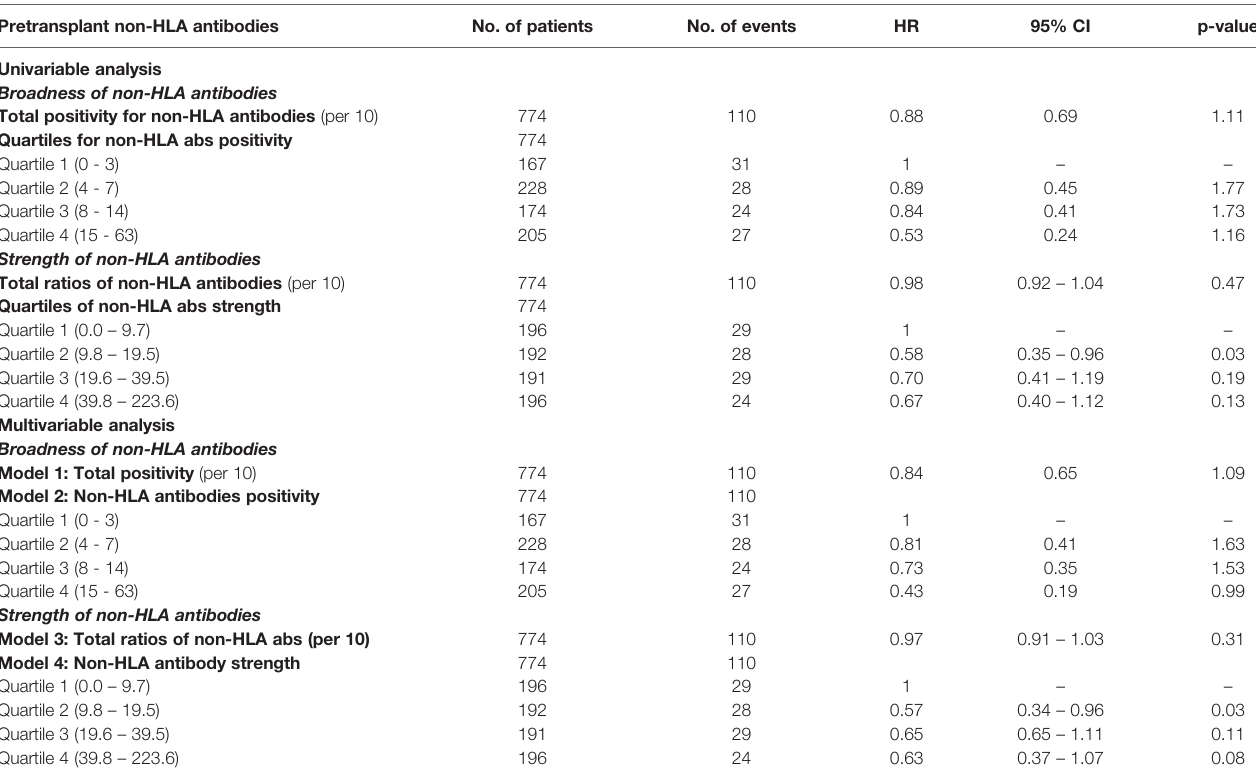
TABLE 4 | Univariable and multivariable Cox proportional hazards analysis of death-censored graft failure, according to the presence of pretransplant non-HLA antibodies in the absence of HLA-DSA (N=774). Pretransplant non-HLA antibodies